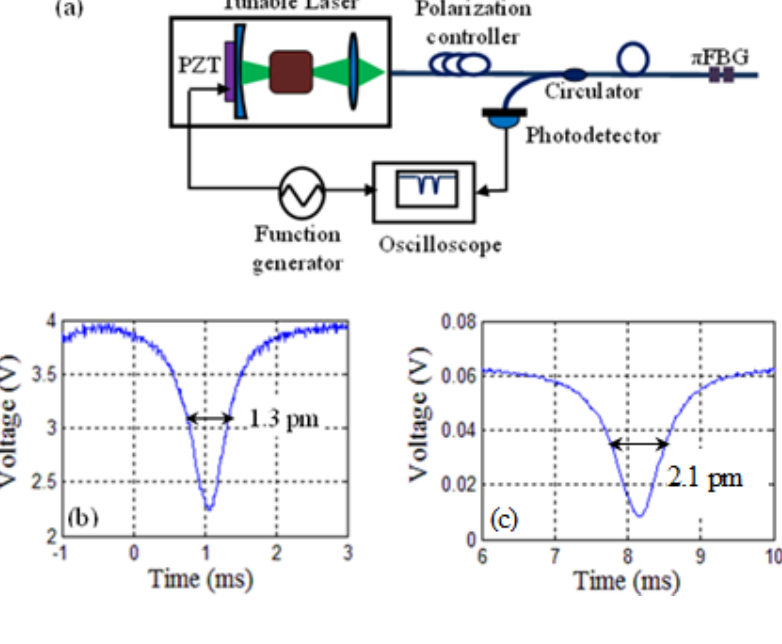
diameter: 9.78 μm; fiber core RI: 1.451; and grating pitch: 535 nm. More specifically, the